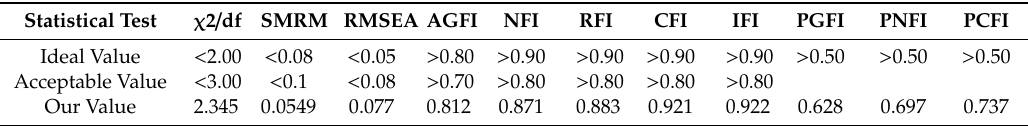
Table 4. Model fitting degree.